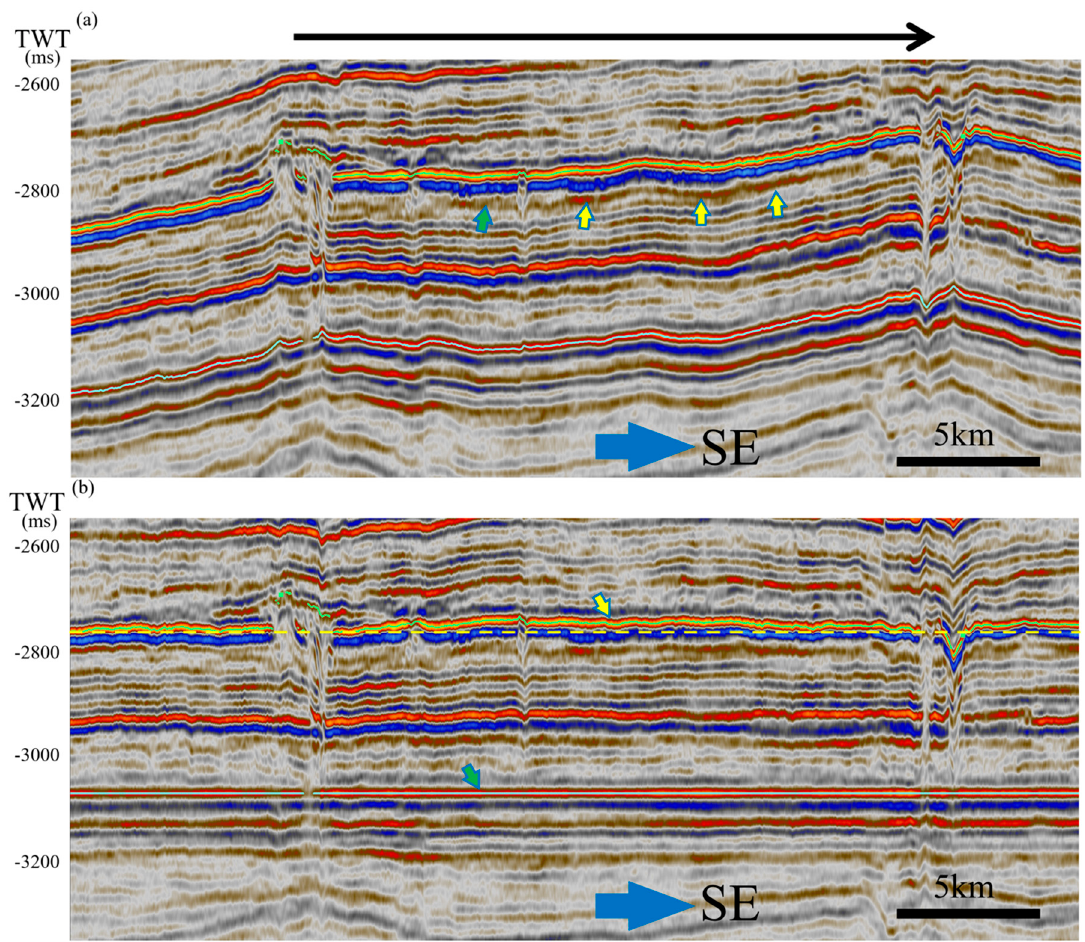
Figure A1. Seismic profile along the red arrow in Figure 4, showing the increasing tuning of basalt reflector. The bottom reflector (blue one) of the basalt layer from the center of the study area is not tuned; while that from the high-thickness area is tuned, which means the thickness of basalt here has reached the tuning limit. Wells T40 and T41, which have basalt thickness of 72 m and 76 m, show tuning effect; while wells T39 and T35, which have basalt thickness of 52 m and 62m, show no tuning effect. This suggests that the tuning point should be slightly lower than 70 m, which is concordant with a tuning point at 25 Hz main frequency and a velocity of basalt at 5800 m/s.